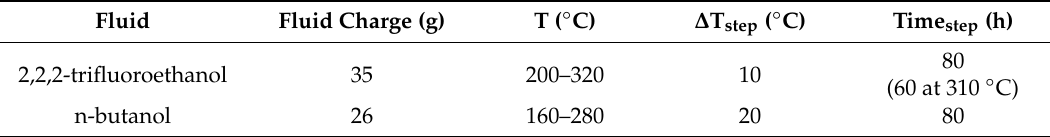
Table 4. Thermal stress tests